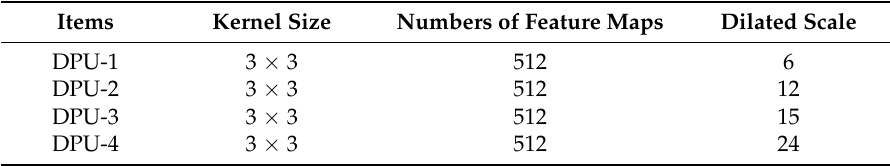
Table 2. Details of dilation convolution units with different dilated